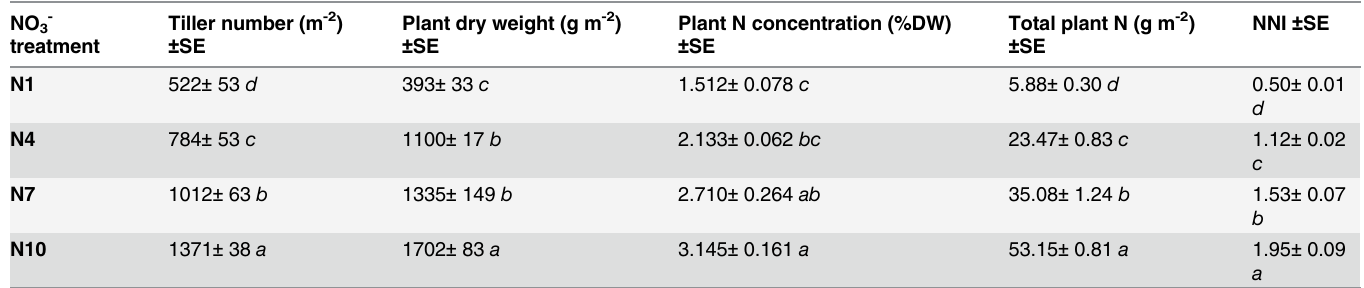
Values are the means of four biological repetitions ± 1 standard error (SE). Statistically non-signi fi cantly different groups (Tukey multiple comparisons, p < 0.05) are labeled with the same lowercase letter. NNI = Nitrogen Nutrition Index.